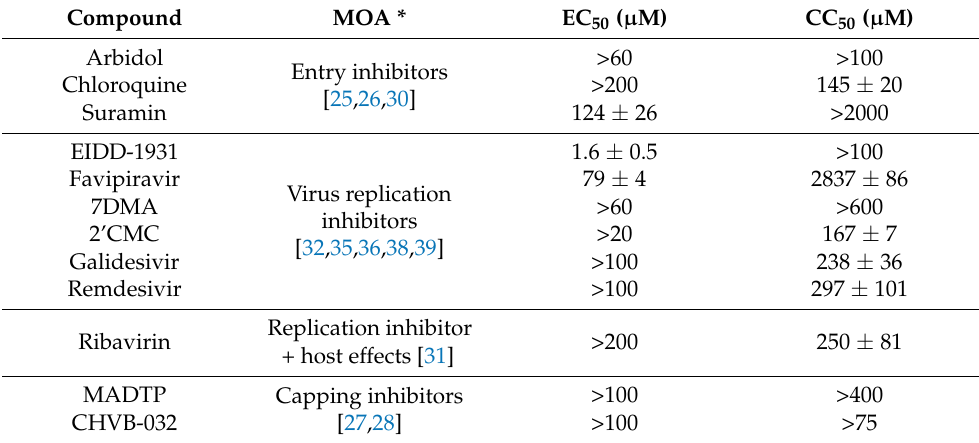
Table 1. EC 50 and CC 50 values of an antiviral compound panel evaluated against